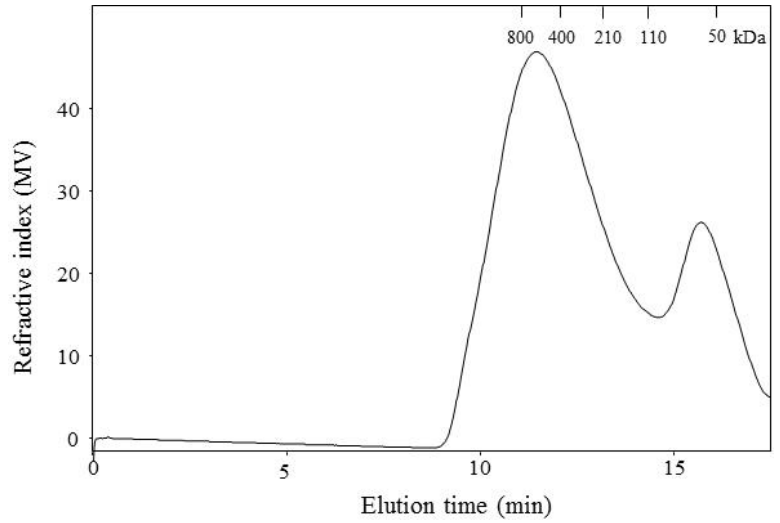
Figure 2. Size-exclusion HPLC elution profiles of WEAX. Retention time of pullulan standards with molecular weight varying from 50 to 800 kDa are